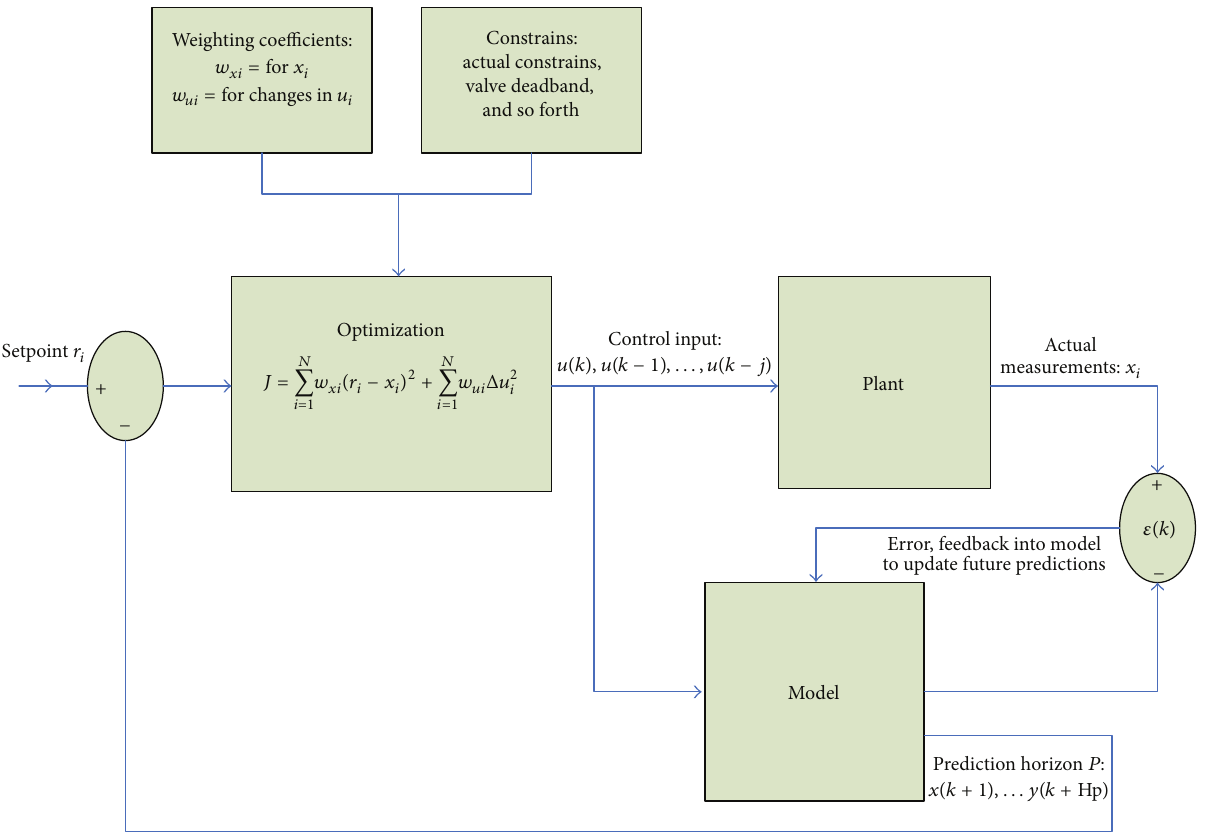
Figure 9: MPC block